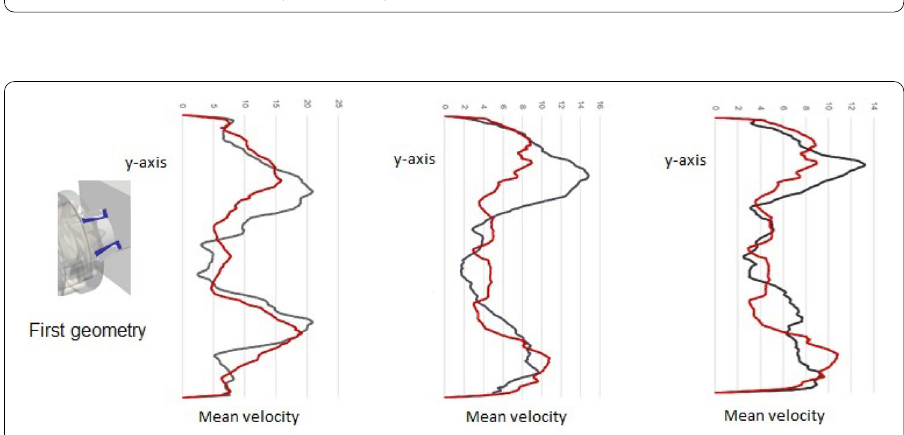
Fig. 55 G1: comparison of the recirculation zones obtained respectively as a consequence of the classical Gappy-POD in red and the HF LES in black